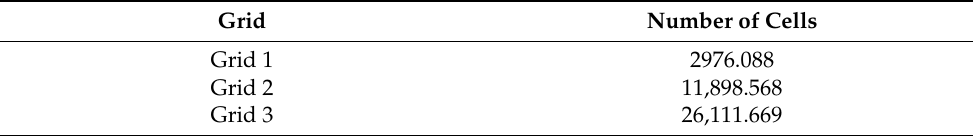
Table 1. Number of total cells for each of the grids considered in the mesh convergence